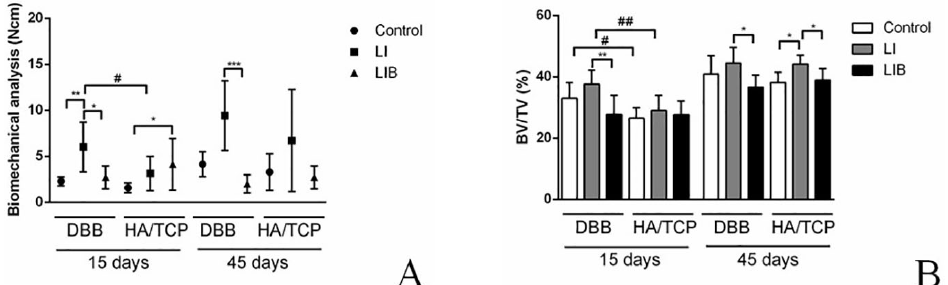
Figure 2- A) Representative graphs of the median and 25th and 75th percentiles of the biomechanical analysis. * p <0.05; ** p <0.01; ***p<0.001 – Significant differences between the different protocols of LLLT (Control, LI, and LIB) - Kruskal-Wallis test complemented by the Dunn test; #p <0.05 – Significant differences between the different bone substitutes - Mann-Whitney U-test. B) Representative graphs of the mean and standard deviation of the micro-CT analysis data. * p <0.05; ** p <0.01 - Significant differences between the different protocols of LLLT (Control, LI, and LIB); #p <0.05; ## p <0.01 – Significant differences between the different bone substitutes – Two-way ANOVA complemented by Tukey’s